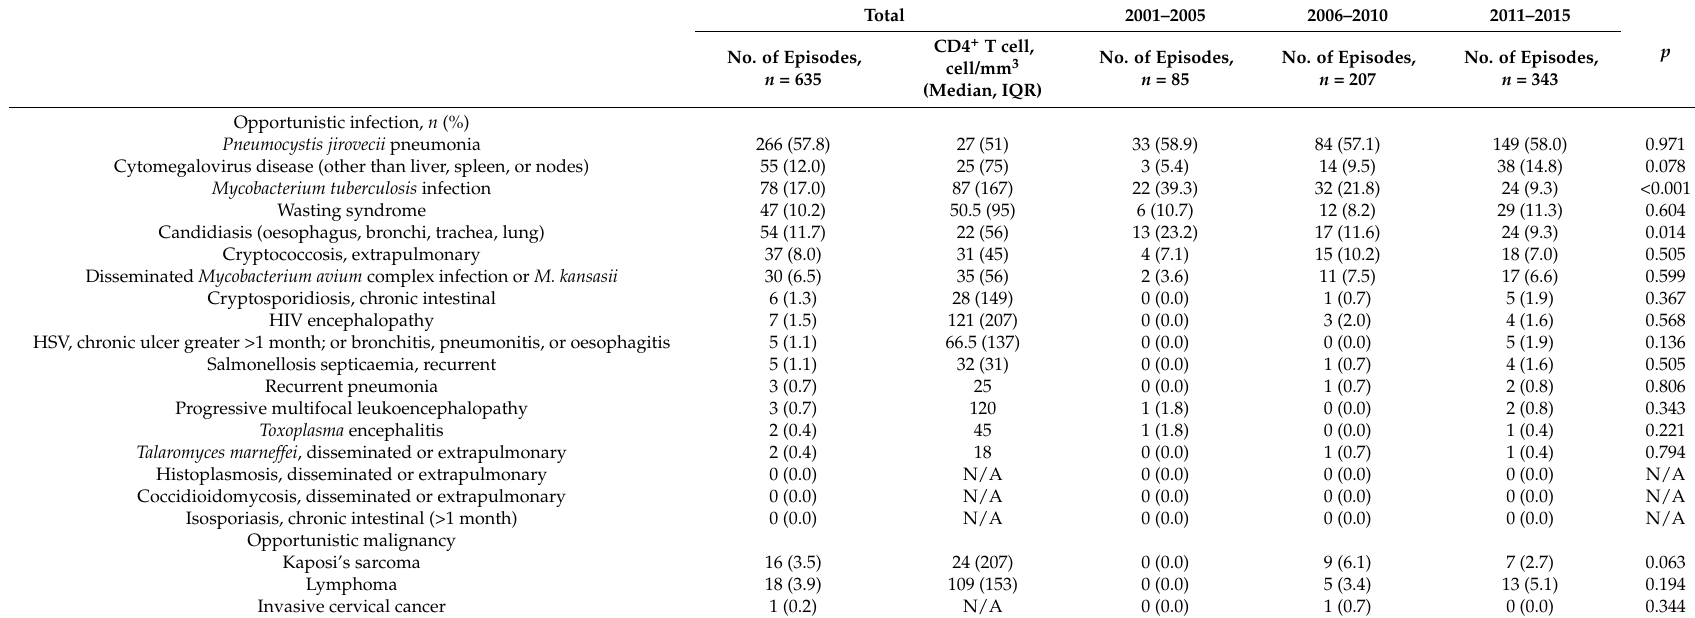
Table 2. Spectrum of AIDS-related opportunistic illnesses (AOIs) with associated median CD4+ lymphocyte counts over the three study